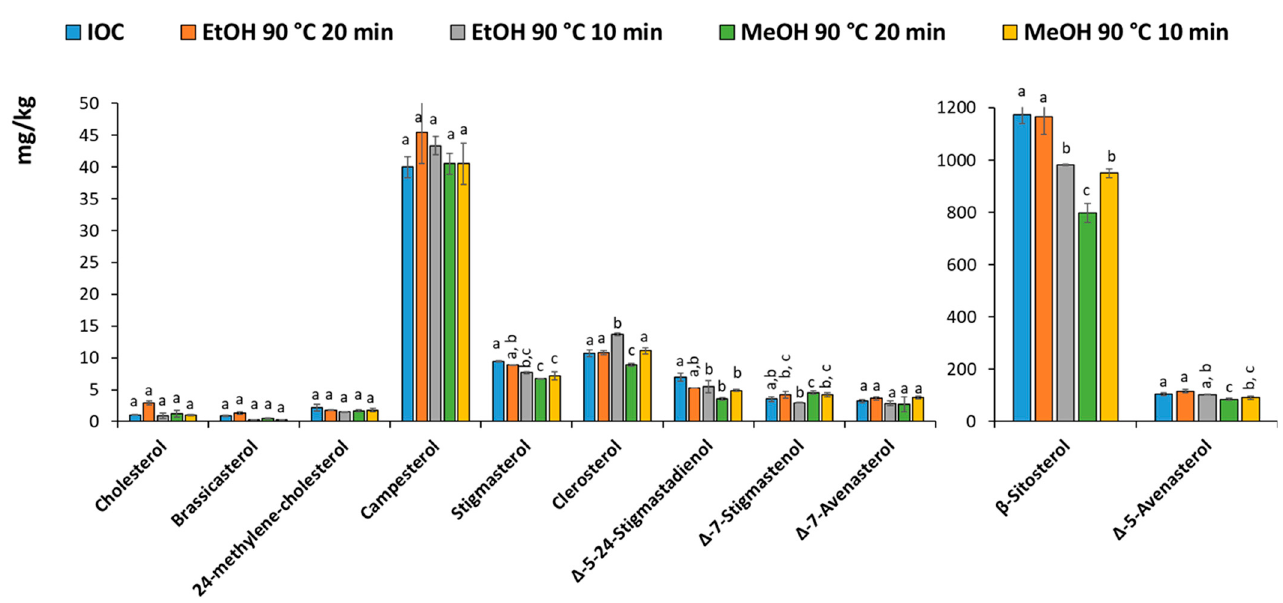
Figure 3. Barplot of the sterols using the IOC method or the different MAS saponification followed by SPE. Same letter indicates no significant difference.